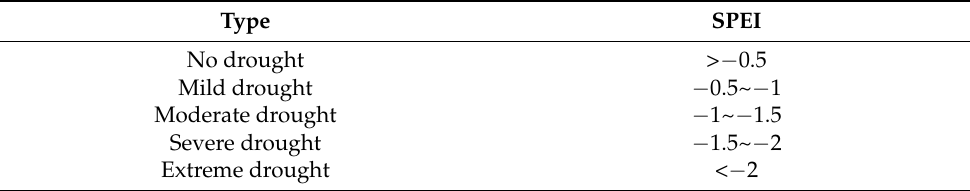
Table 1. Classification of drought